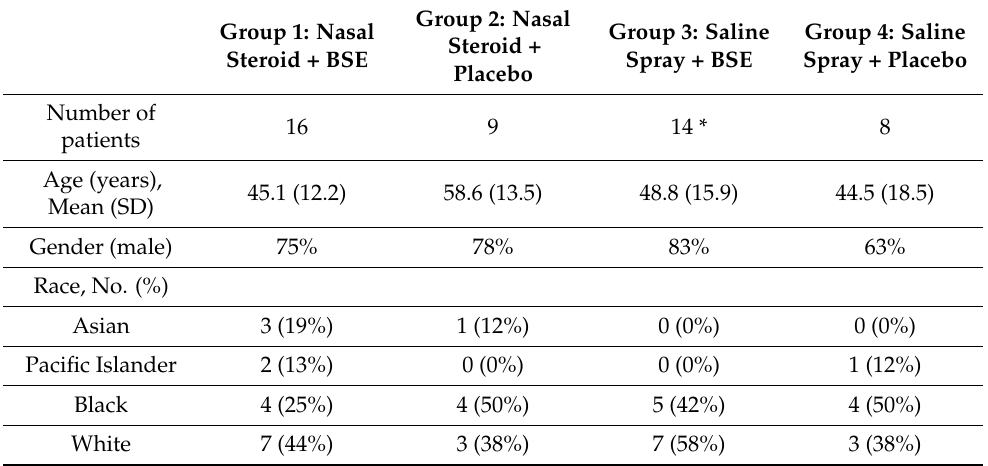
Table 1. Subject description for each group, including: age, gender and